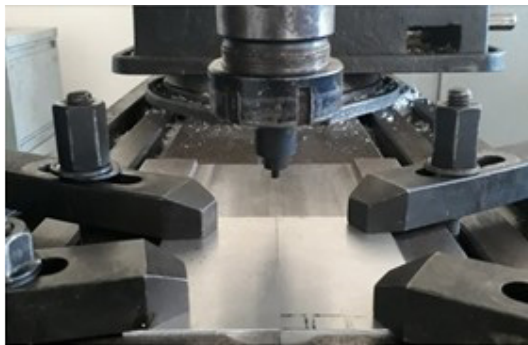
Figure 2. Fixing plates for welding execution.